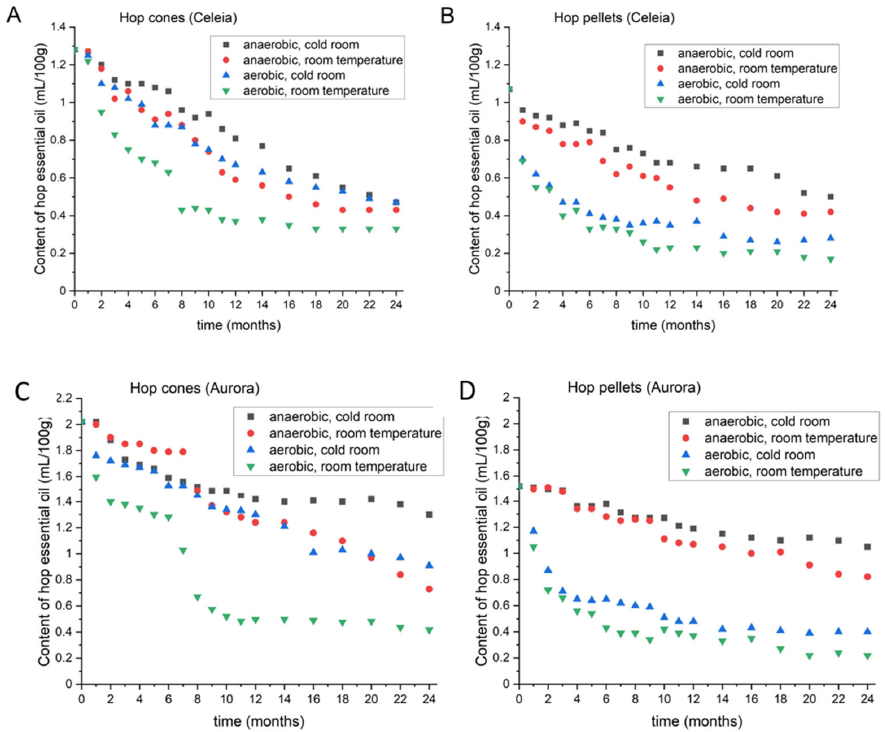
Figure 1. Changes in the content of hop essential oil in Celeia cones ( A ) and pellets ( B ) and Aurora cones ( C ) and pellets ( D ) during two ‐ year period, under different storage